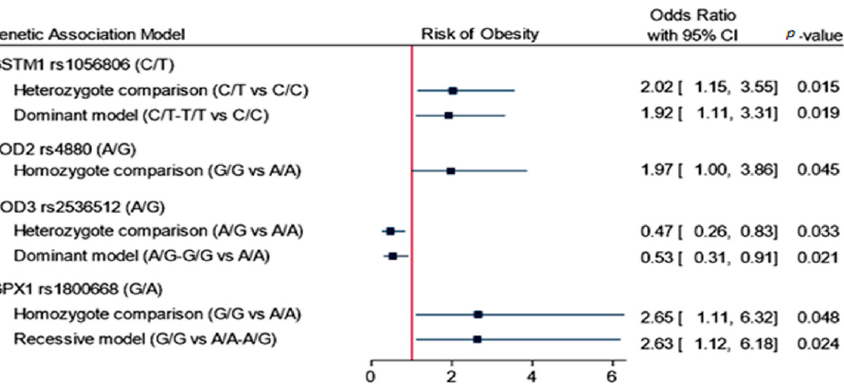
Figure 1. Association of genetics variant panel with the risk of obesity. Data are presented as the odds ratio and 95% confidence interval (CI). p -value < 0.05 was considered as statistically significant. Binary logistic regression analysis was adjusted for age and sex.